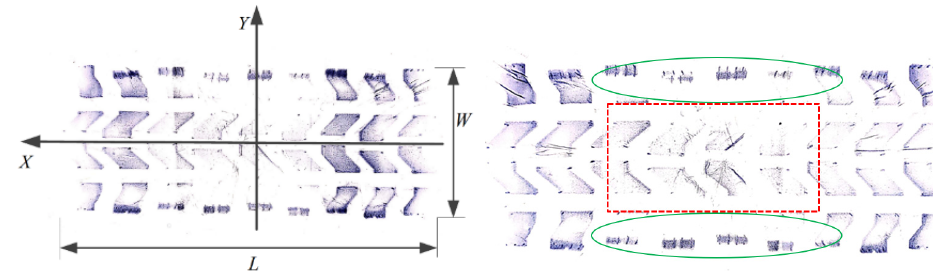
Figure 2. Contact patch under the zero-pressure condition.